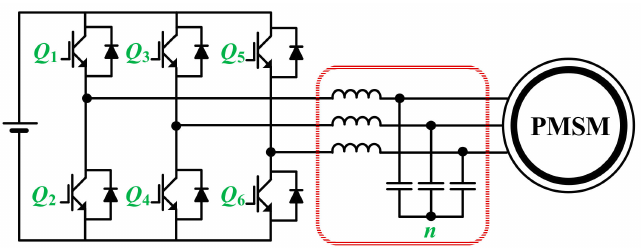
Figure 1. Schematic diagram of permanent magnet synchronous motor (PMSM) equipped with LC